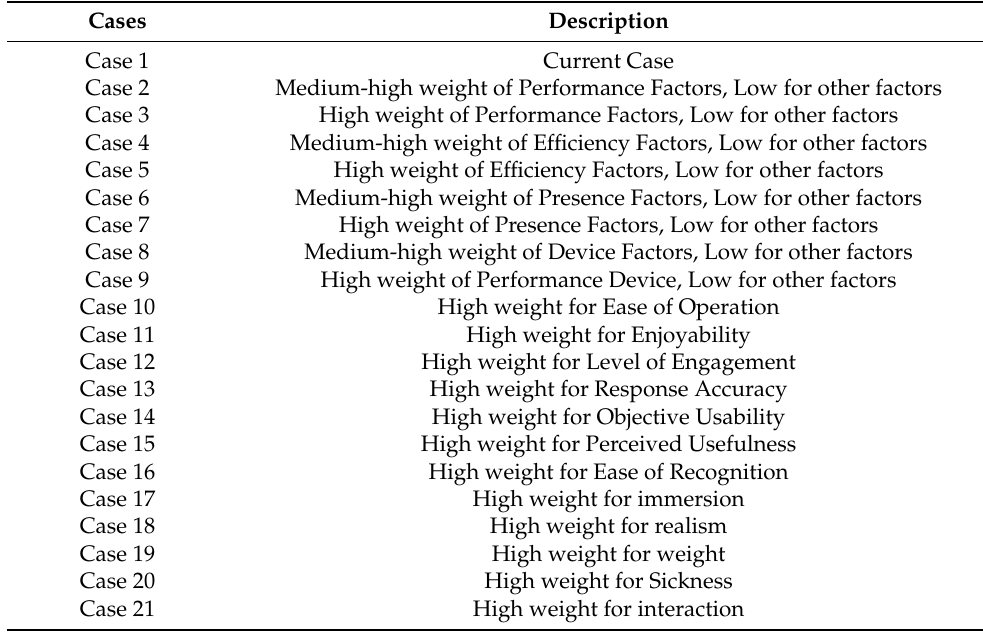
Table 11. Sensitivity analysis case